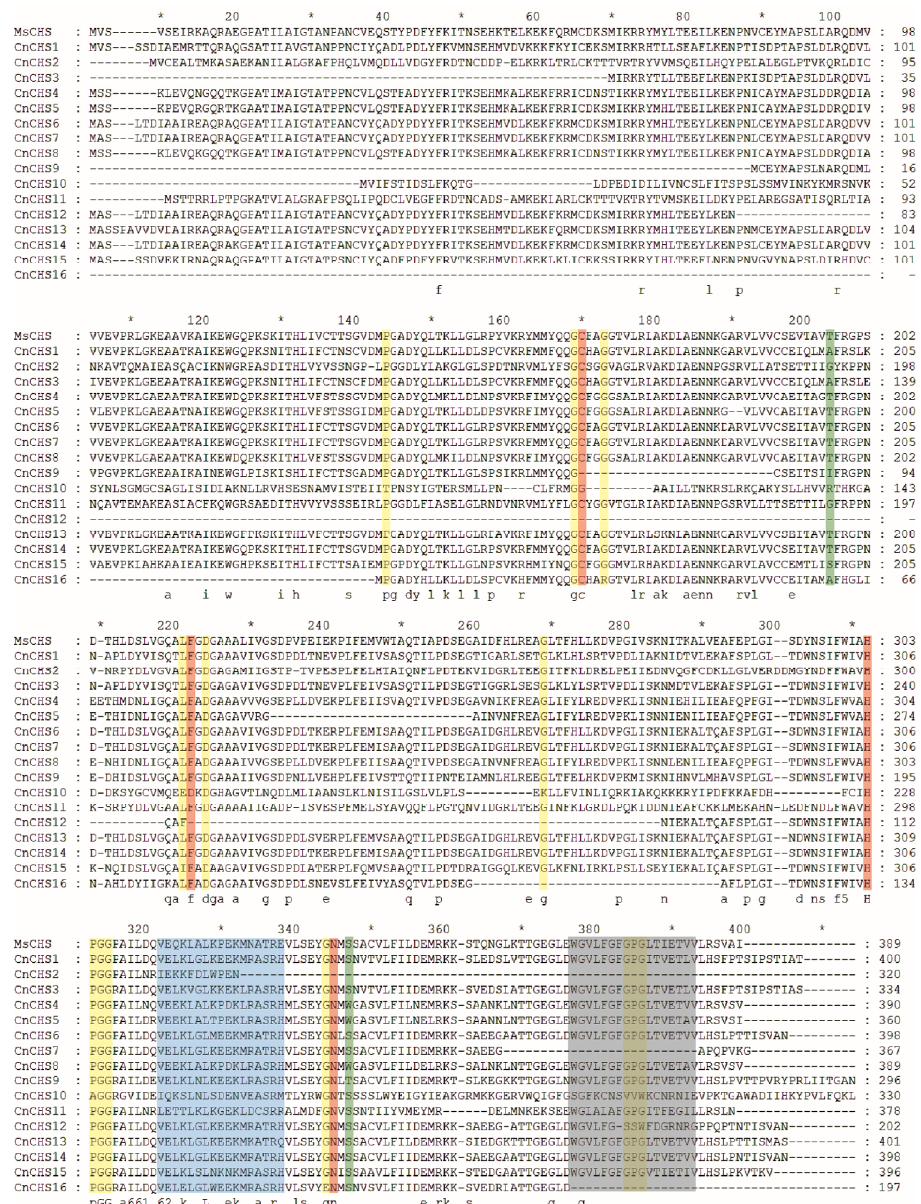
Figure 1. A comparison of amino acid sequences between alfalfa MsCHS2 and CnCHS. Functionally important conserved residues are marked with differently colored backgrounds. The four catalytic residues are highlighted with red. Inactive active catalytic sites are highlighted with yellow. Important residues that affect the binding pocket volume and the cyclization pocket are highlighted with green. Malonyl-CoA binding sites and signature sequences are highlighted with blue and gray, respectively. The amino acids are numbered based on those of alfalfa MsCHS2.